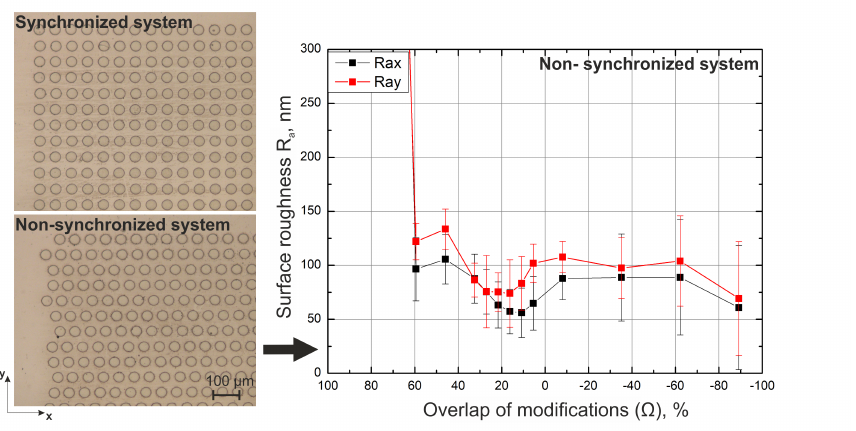
Figure 9. Picture of the surface after a single-pass ablation when the system is synchronized (on the top left picture). Picture of the surface after a single-pass ablation when the system is not synchronized (on the bottom left picture). Surface roughness dependence on the overlap of the modifications when the system is not synchronized (on the right ). Used laser source—number 1.